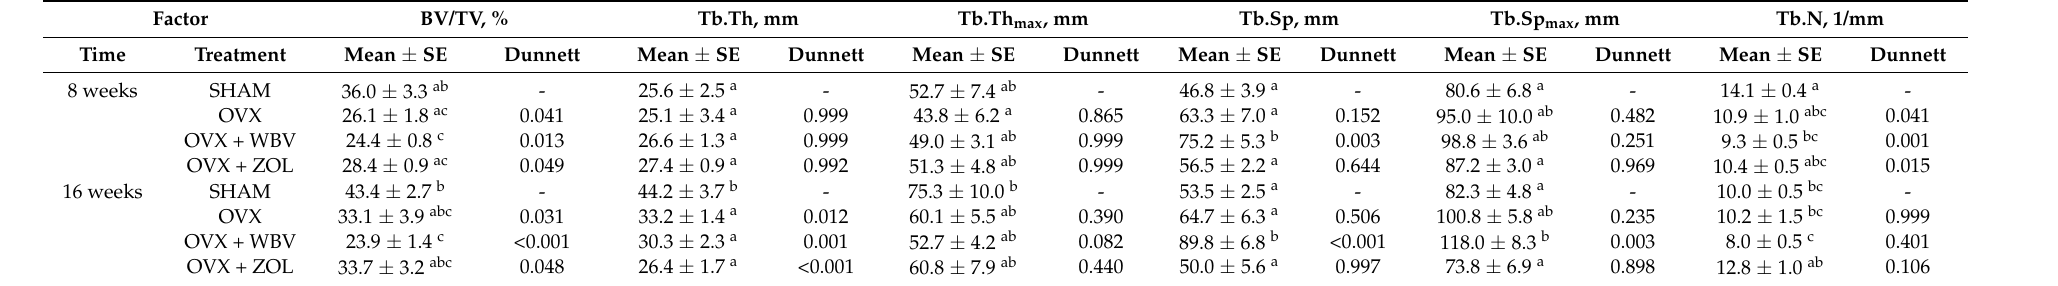
Table 2. The trabecular bone histomorphometry in femur metaphysis in the study